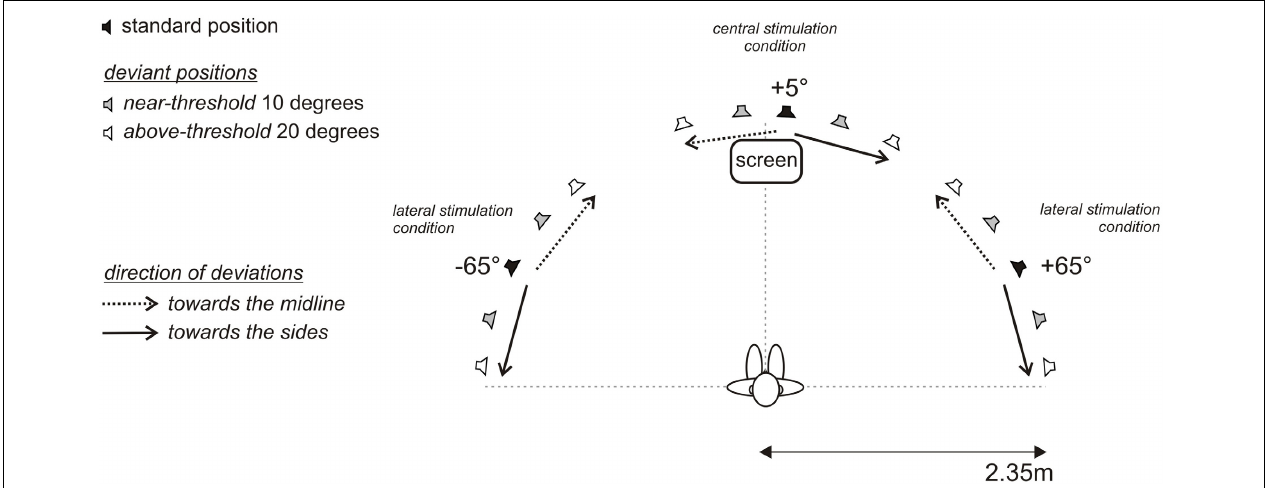
respectively (horizontal dashed line). In three blocks standard signals were presented at − 65 ◦ , + 5 ◦ , and + 65 ◦ , (black loudspeaker symbols), and respective deviant signals were spatially displaced by 10 ◦ (gray loudspeaker symbols) and 20 ◦ (white loudspeaker symbols) toward the midline (dotted arrow) and the sides (solid arrow). Subjects were instructed to ignore the acoustic stimulation and to attend a muted movie with subtitles presented on a screen frontally at 0 ◦